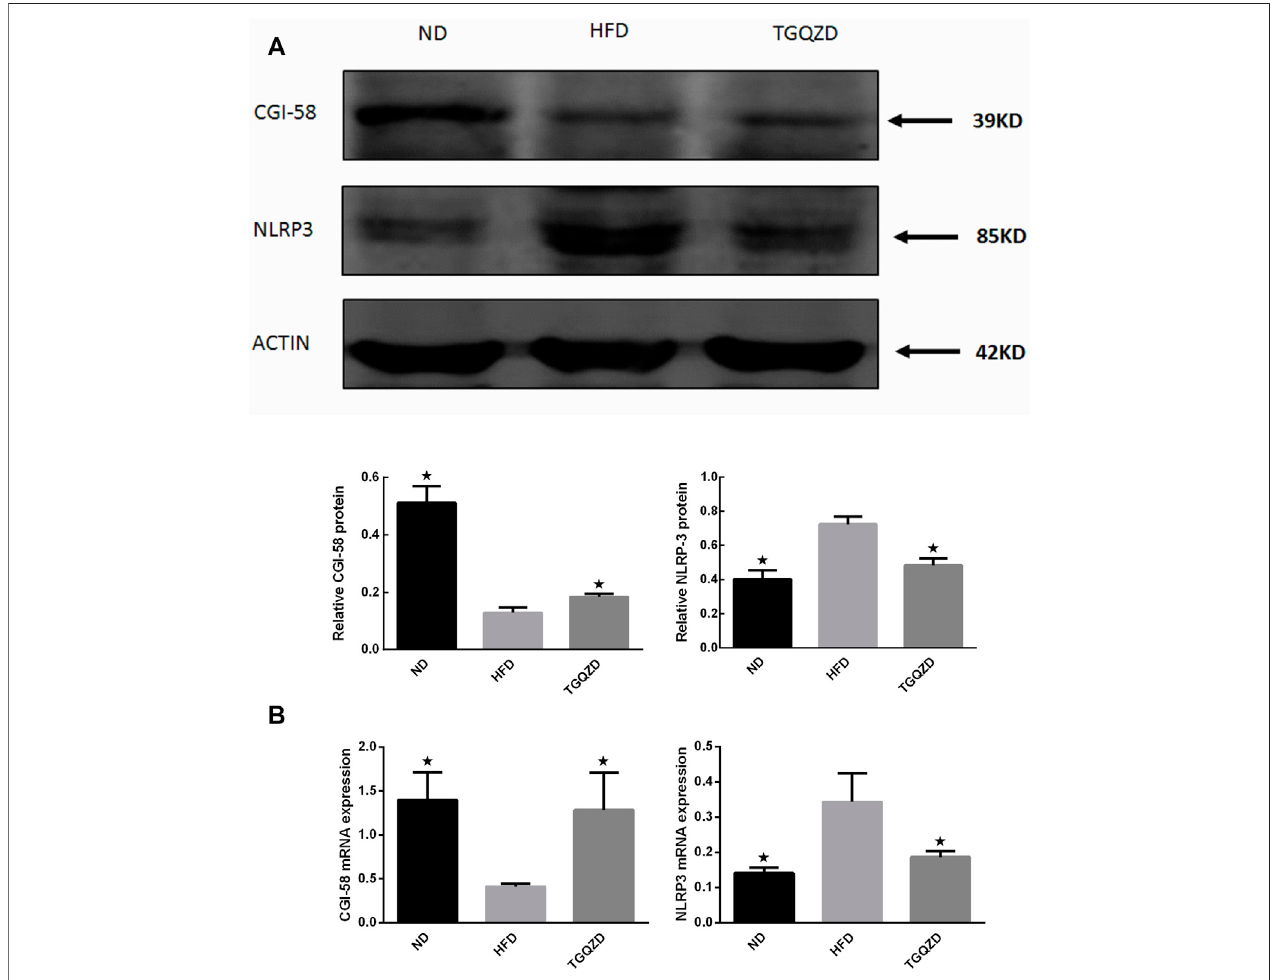
FIGURE8| EffectofTGQZD on CGI-58 and NLRP3 in fl ammasome ofliverin NAFLDrats. (A) Representative images ofWesternblotshowingCGI-58 and NLRP3 in fl ammasome protein expression in NAFLD rats in the different groups. (B) Quantitation of CGI-58 and NLRP3 in fl ammasome mRNA expression in NAFLD rats in different groups. ACTIN was used as a loading control. * p < 0.05 vs. HFD Group, alone, ( n = 3).